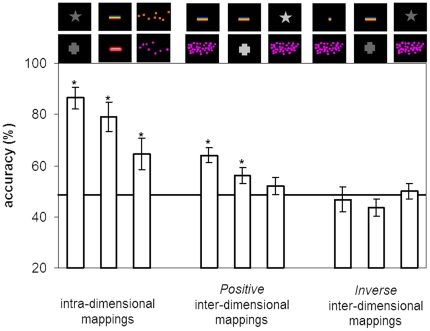
Overall mean accuracy (%) for the intra-dimensional mappings of brightness, length, and number, and the inter-dimensional mappings of length/number, length/brightness, and brightness/number, in both positive and inverse directions.The horizontal bar represents accuracy at chance (50%). The asterisks above the bars denote that performance was significantly above chance.